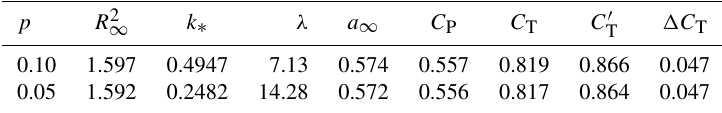
Table 1. Results for the expanding Joukowsky wake with constant pitch.